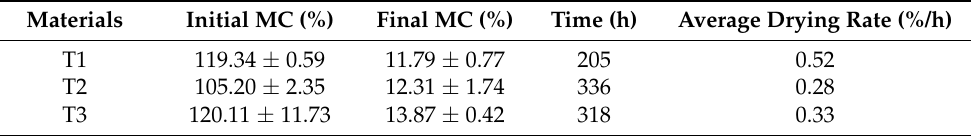
Table 2. Final moisture content after drying.